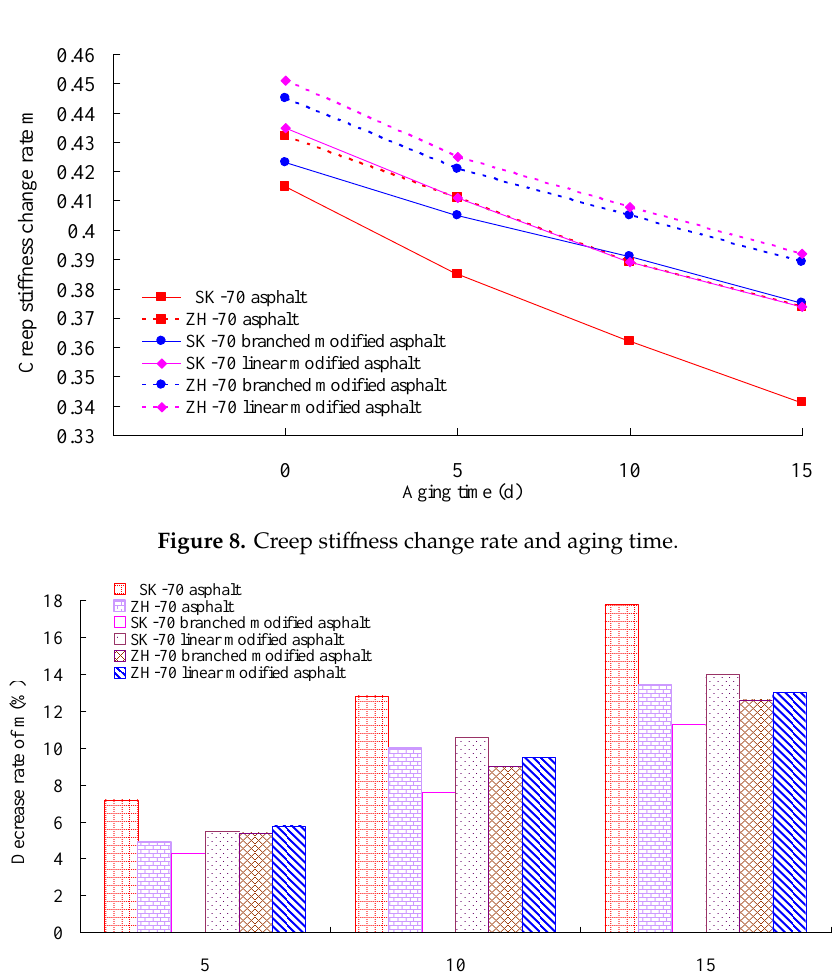
Figure 9. Decrease rate of creep stiffness change rate and aging time.